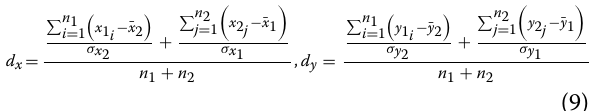
away from o , reach _ dist k ( p , o ) = d ( p , o ) . When an